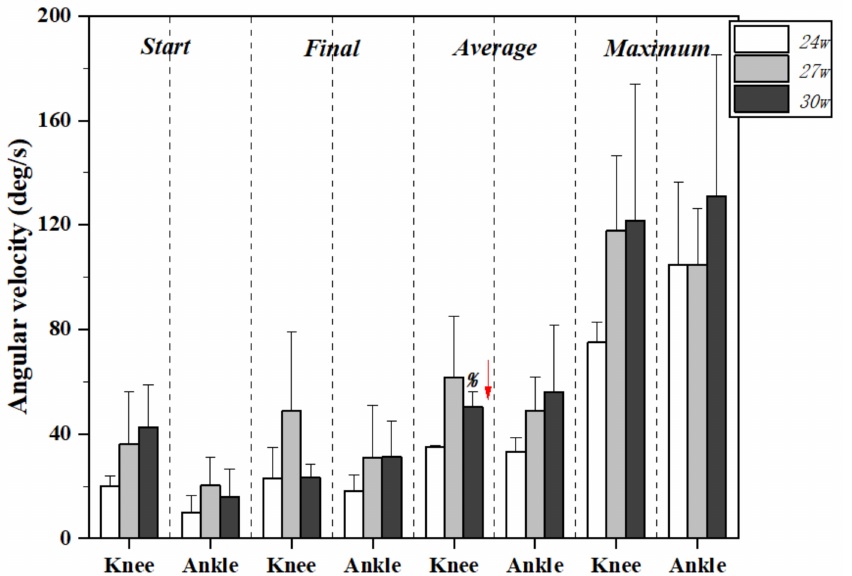
Figure 3. Lower limb joint angular velocity changes during kicking motion at 24, 27, and 30 gesta- tional weeks. Note: % indicates significant differences between 24 w and 30